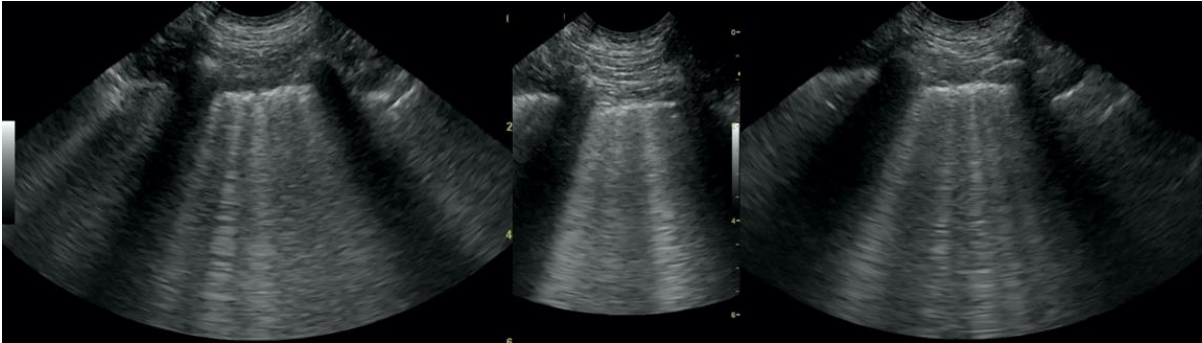
Figure 2. Multiple B-lines. Figure 2. Multiple